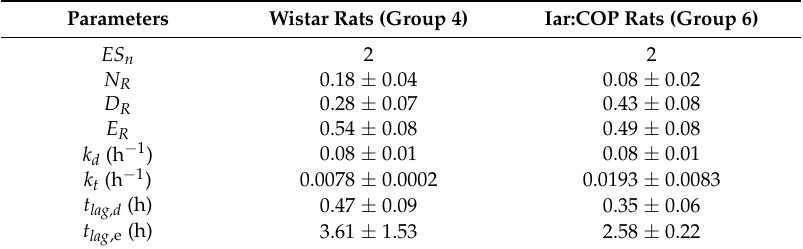
Table 2. The estimated parameters used to predict the PKs of leuprolide in the SR-administered group using developed PK model (mean ± SE, n =